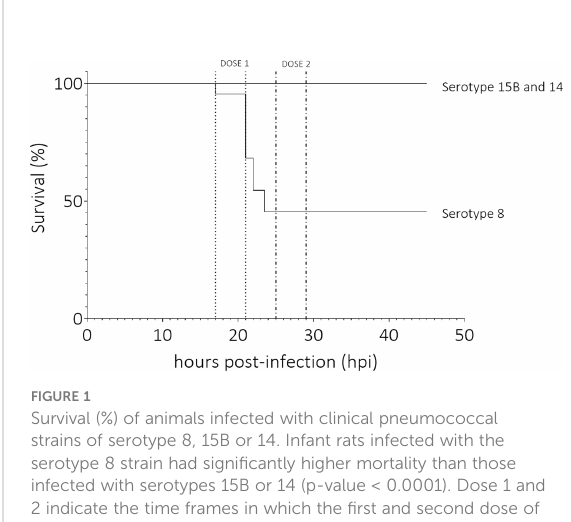
signi fi cantly higher bacterial titre than animals infected with serotype 14 (p-value = 0.0051). The average weight did not differ between the groups at inoculation (serotype 8: 25 g, sd ± 3.9;